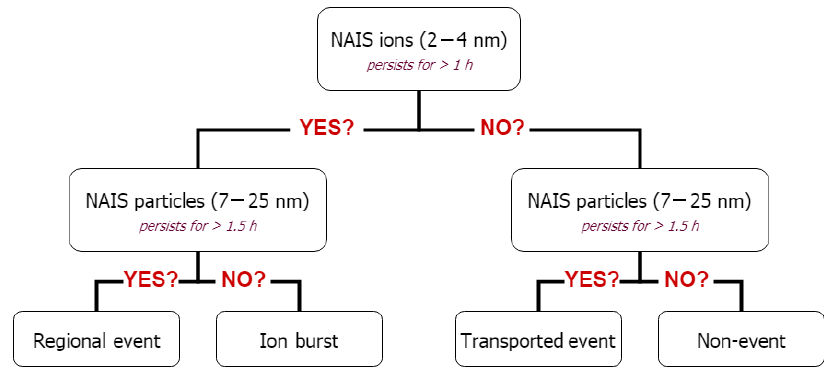
Figure 1. A flow chart for the decision path during event classification in Hyytiälä using the new classification method.